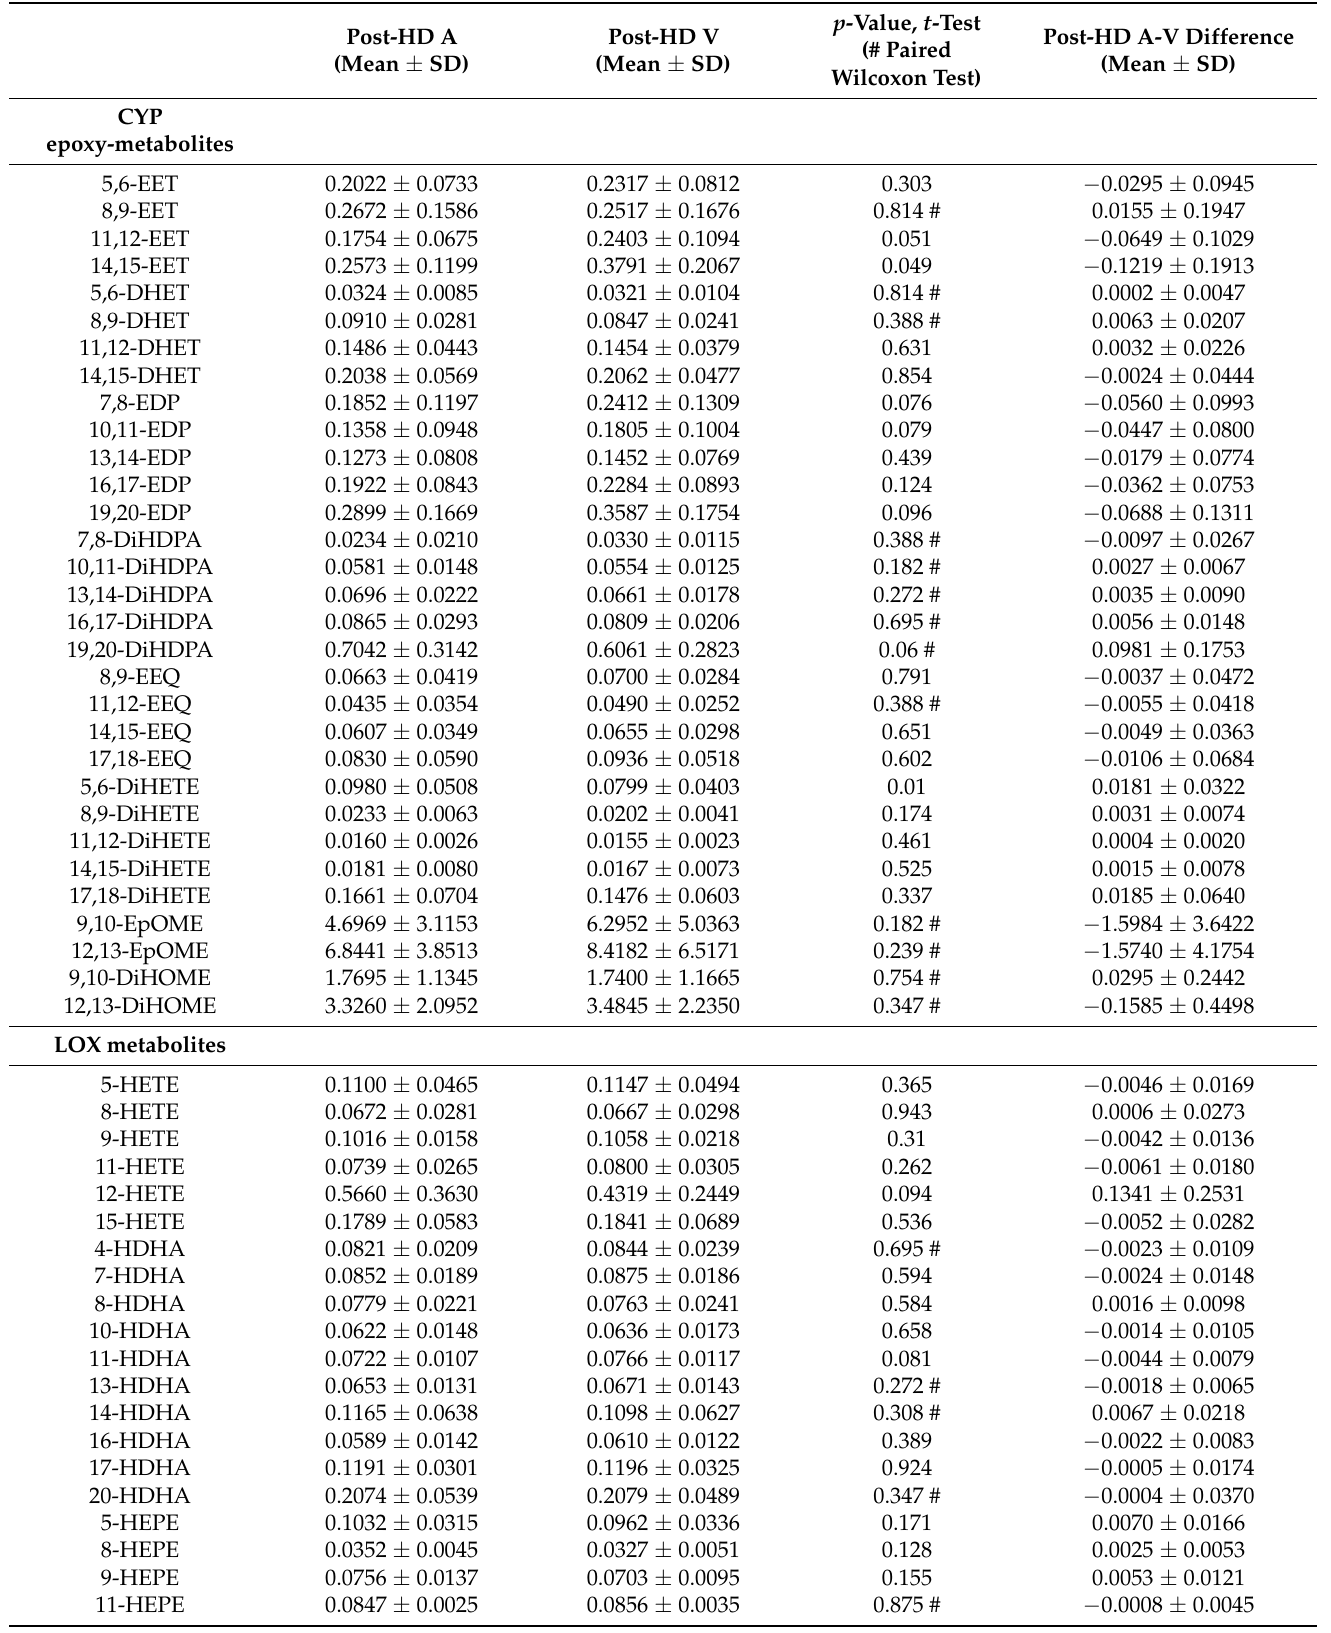
Table 4. Effects of hemodialysis on free oxylipins in the CKD patients at cessation (post-HD) of hemodialysis ( n = 12